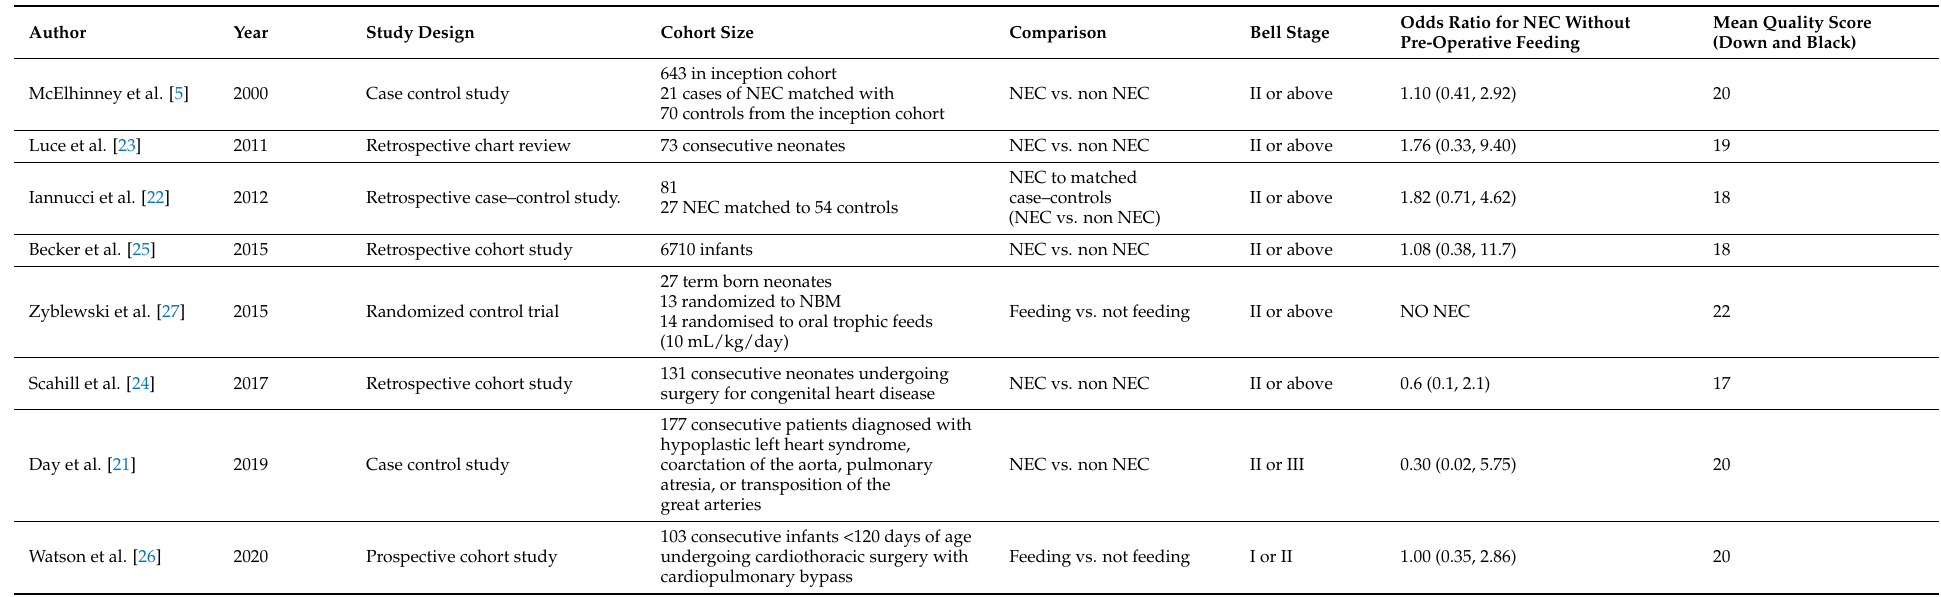
Table 1. Eight studies included in the meta-analysis in chronological